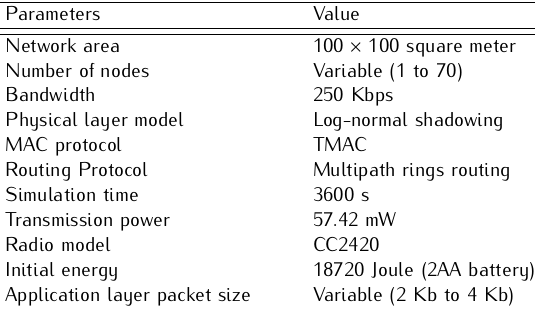
Table 2. Simulation environment parameters.